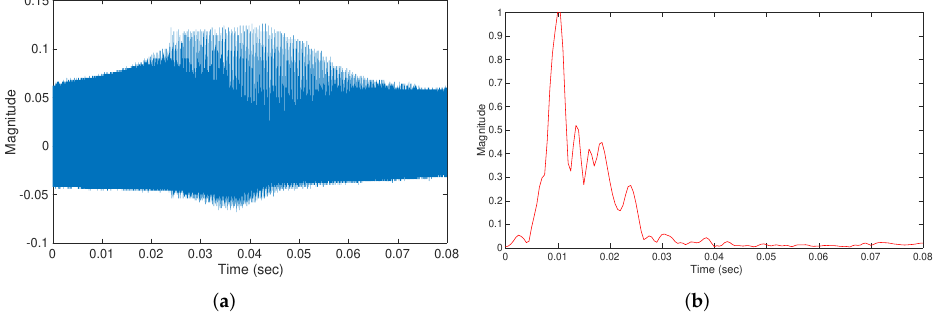
Figure 5. Received signal before and after processing. ( a ) Raw received signal y[n]. ( b ) Received signal before and after